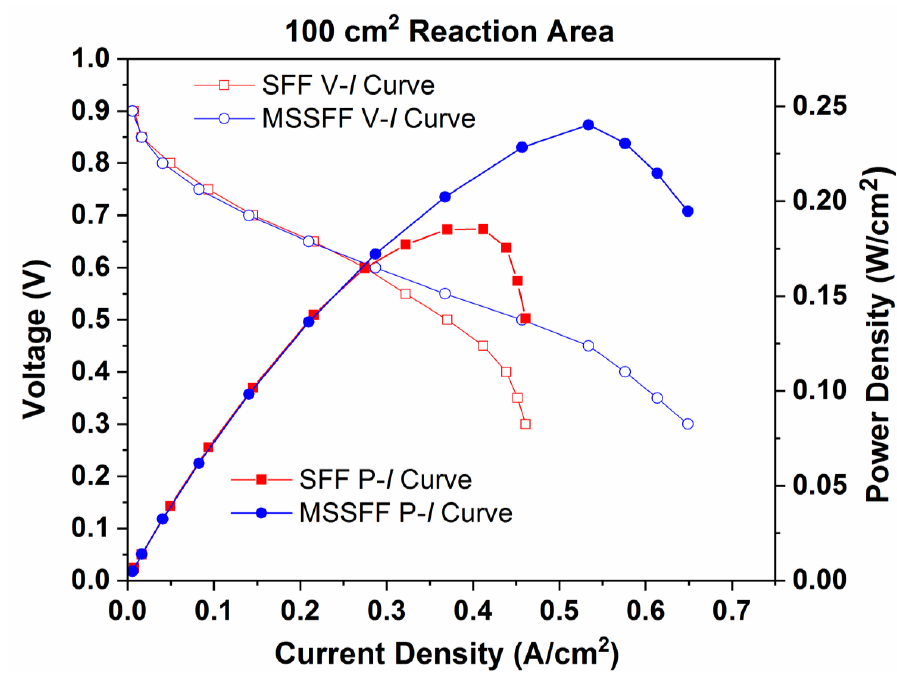
Figure 10. Performance (P–I) curves and Polarization (V–I) curves for SFF and MSSFF on cathode side with 100 cm 2 reaction area.